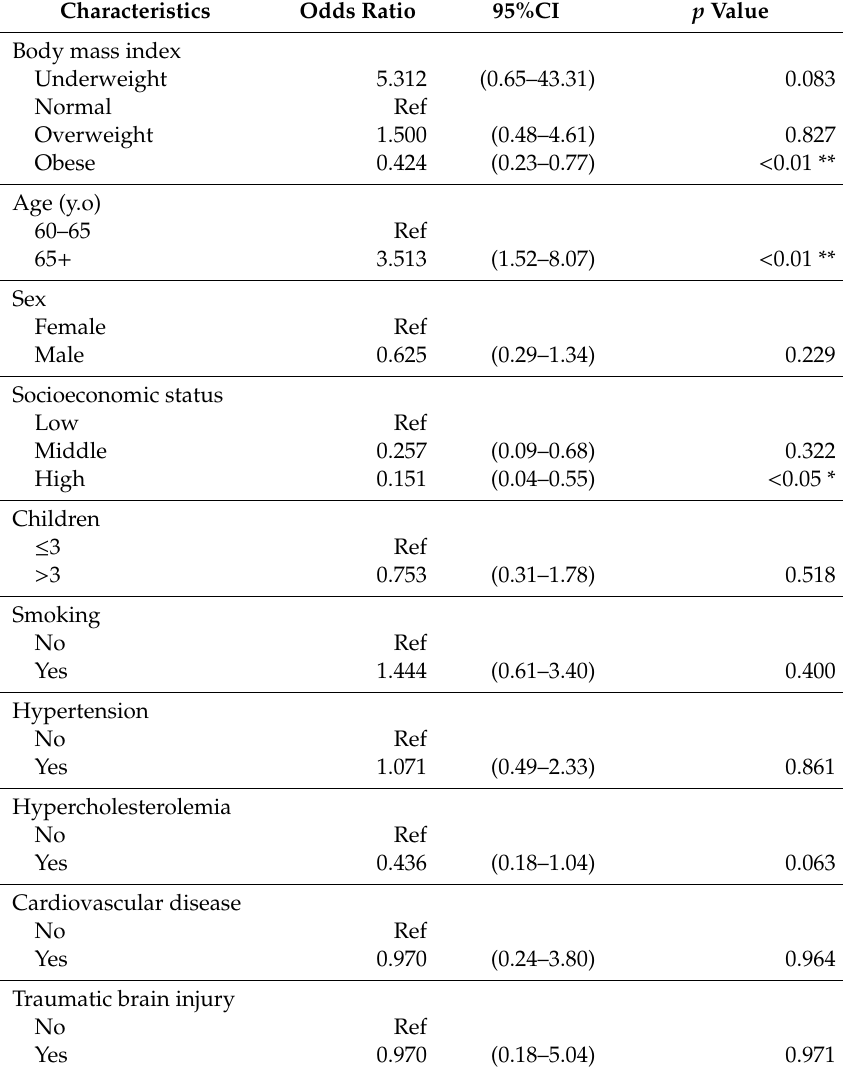
Table 2. Univariate analysis of factors associated with cognitive